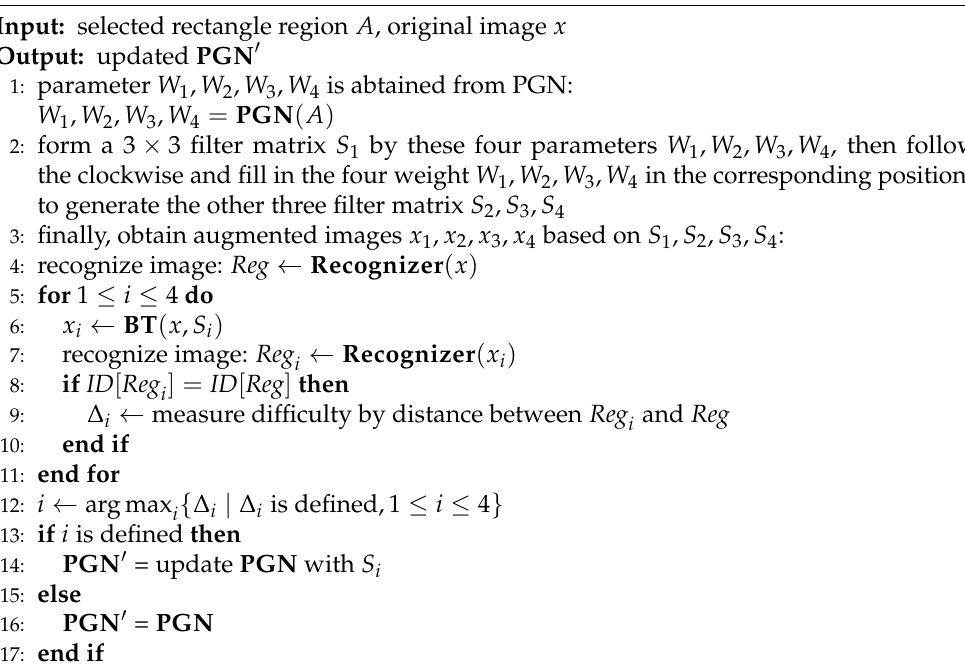
Algorithm 2 Adversarial process of PGN and the